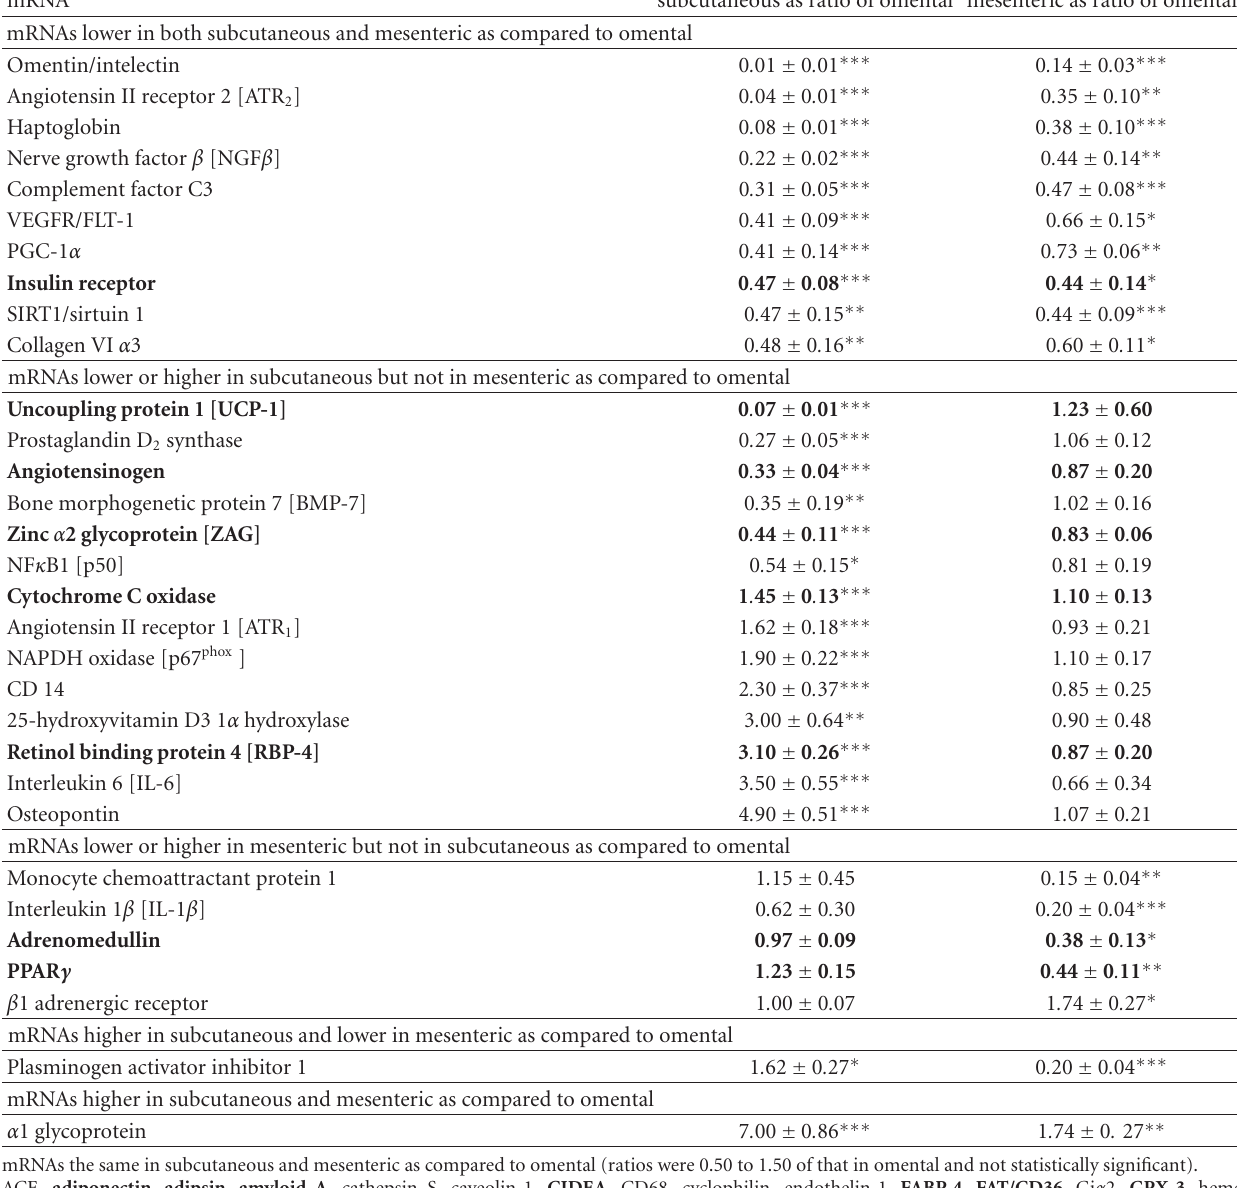
Table 4: Comparison of mRNAs in human mesenteric and subcutaneous as compared to omental adipose tissue from extremely obese women. mRNA subcutaneous as ratio of omental mesenteric as ratio of omental mRNAs lower in both subcutaneous and mesenteric as compared to omental Omentin/intelectin 0 . 01 ± 0 . 01 ∗∗∗ 0 . 14 ± 0 . 03 ∗∗∗ Angiotensin II receptor 2 [ATR 2